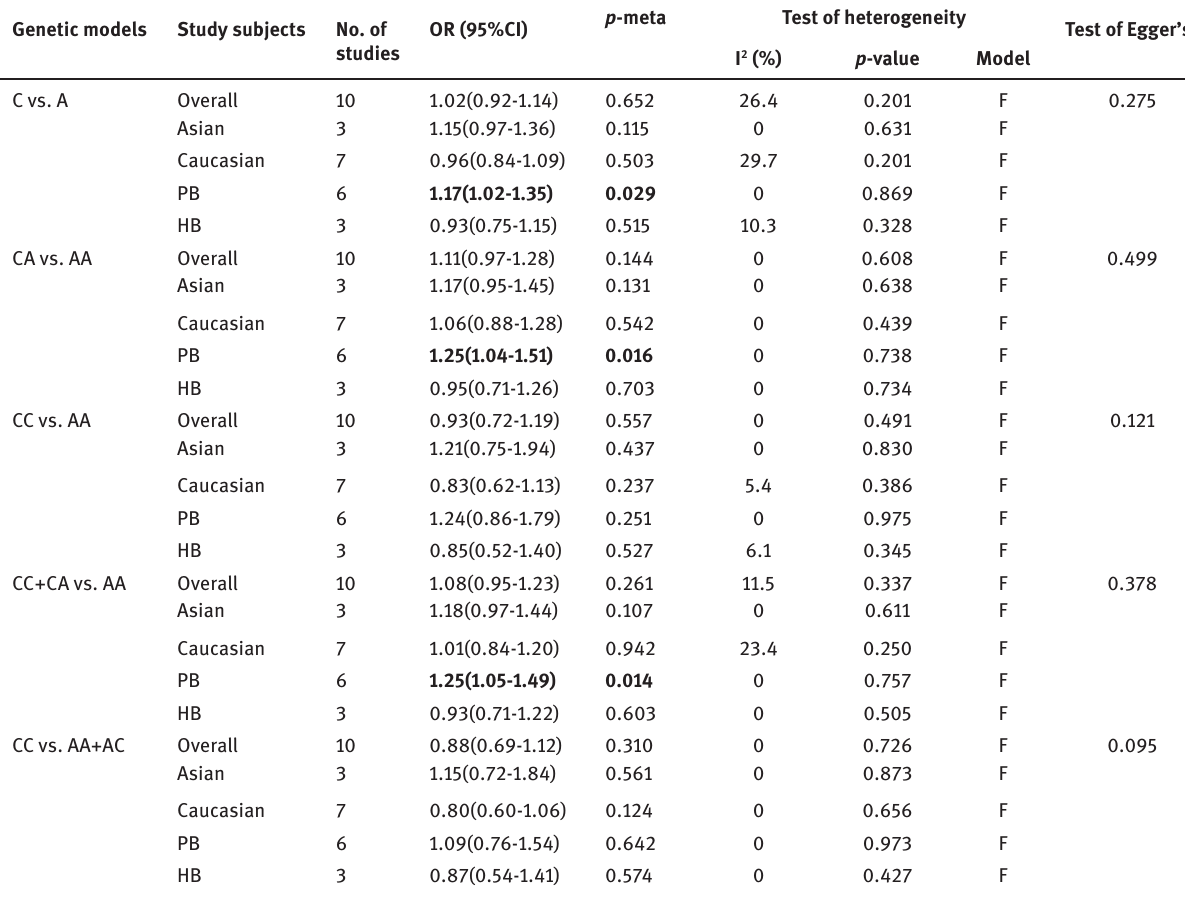
Table 3: Summary ORs and 95%CI of the association between A1298C polymorphism and Parkinson disease susceptibility.